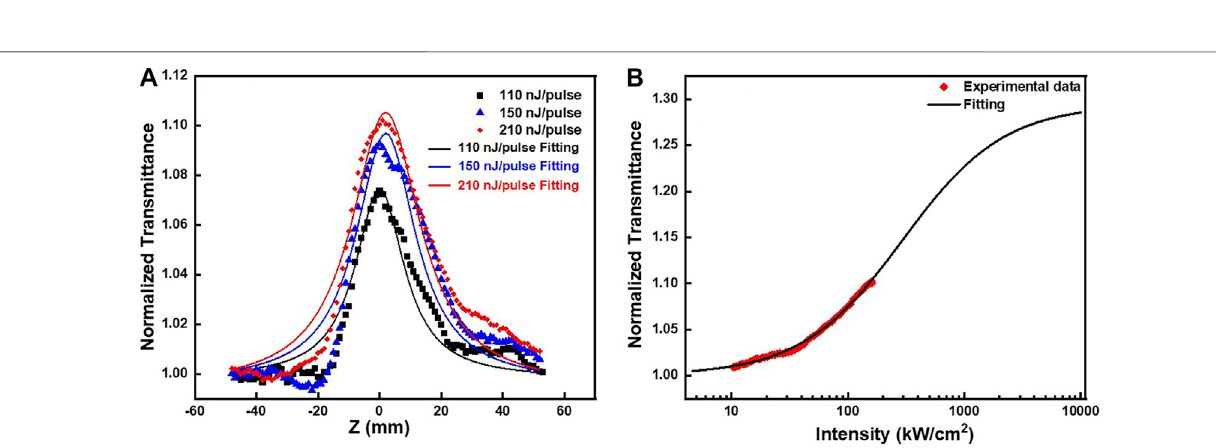
Frontiers in Physics |